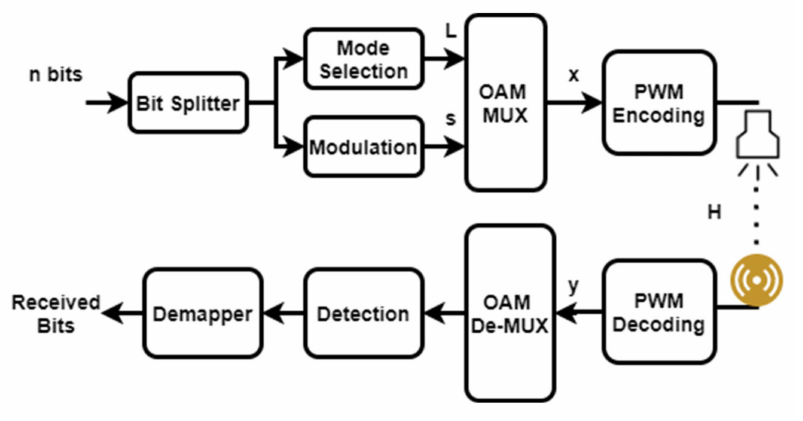
Figure 3. System block diagram of